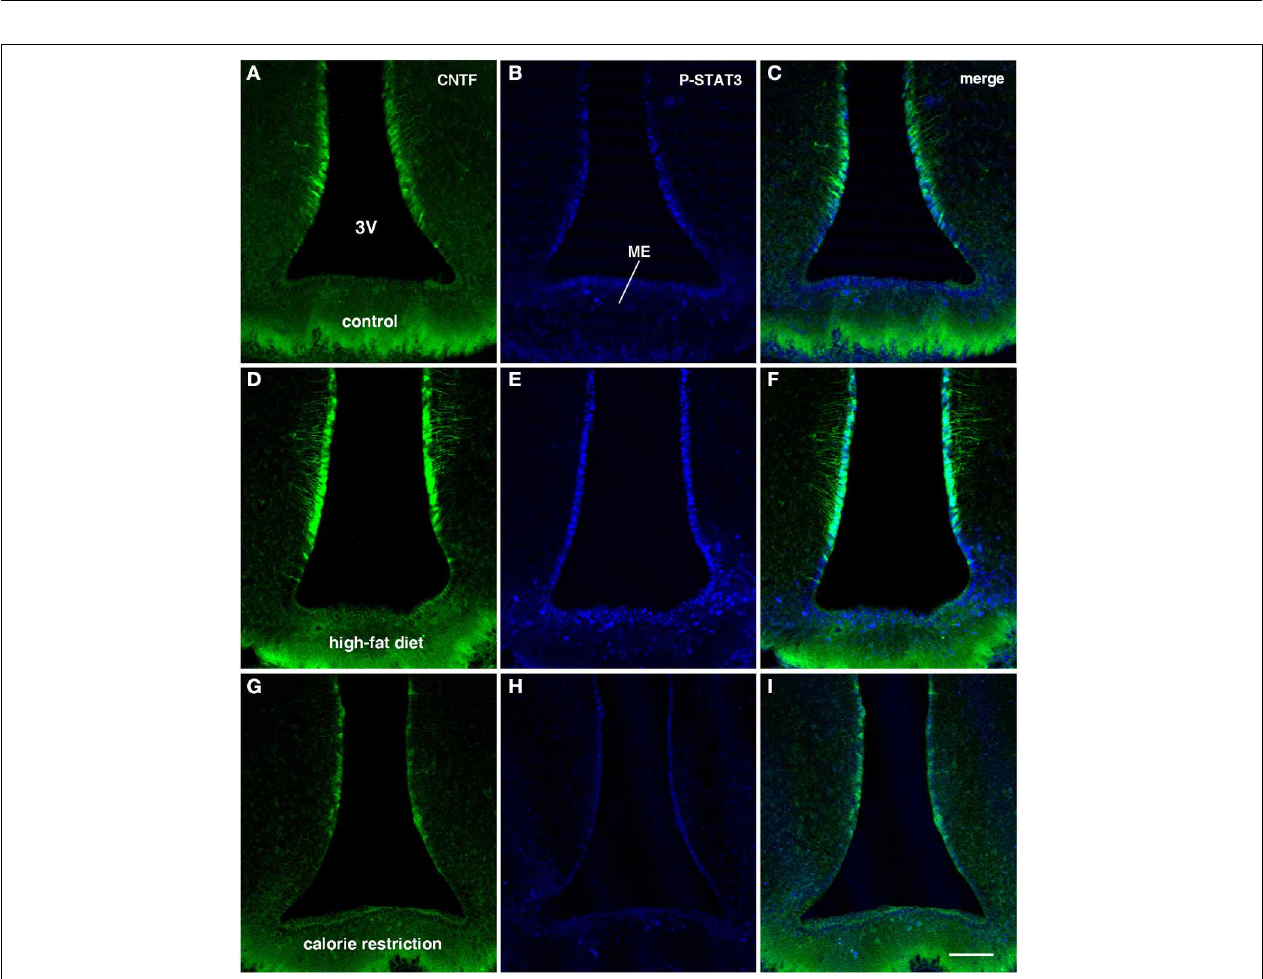
arrowheads) intense staining of their long projections. In contrast, tanycytes in CR mice (C) exhibit very low-level staining. The insets of (A,B) are the enlargements of the corresponding framed areas. ME, median eminence. Bar: (A–C) 400 μ m; inset of (A) 40 μ m; inset of (B) 300 μ m.